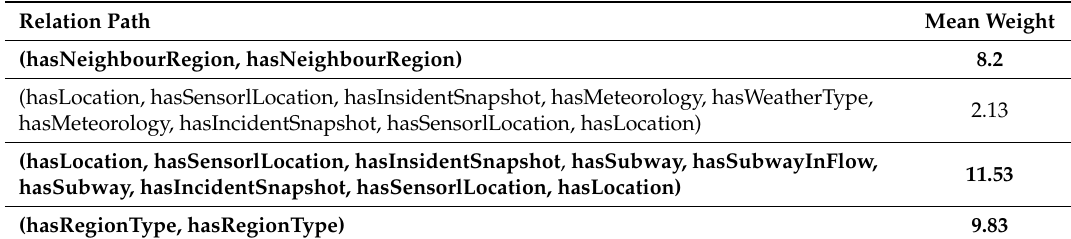
Table 6. Explanations of the results based on global graph features for optimal store placement. Relation Path